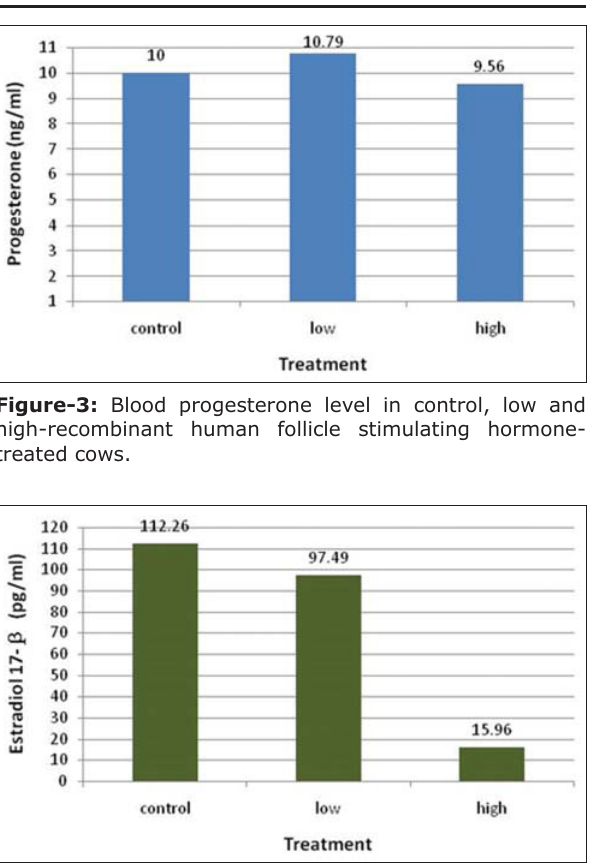
Figure-4: Blood estradiol 17- β level in control, low and high-recombinant human follicle stimulating hormone- treated